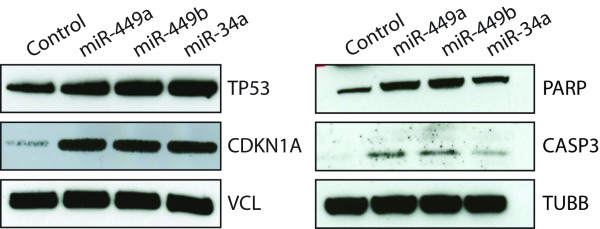
miR-449 activates the p53 pathway. Western blot analysis showing an increase of the p53 protein upon miR-449 and positive control miR-34a re-introduction into SNU638 cells compared to RNA scrambled control as well as an activation of the p53 downstream target p21 and apoptosis markers cleaved CASP3 and PARP. Vinculin (VCL) and tubulin beta (TUBB) were used as loading controls.